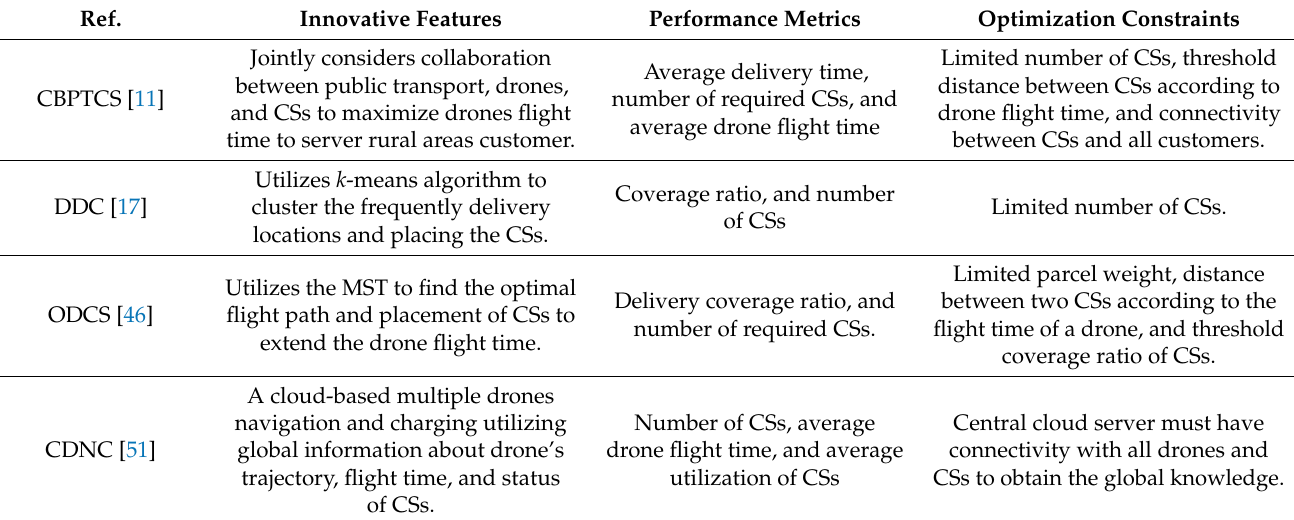
Table 5. Comparison of charging algorithms in drone routing in terms of innovative features, performance metrics, and optimization constraints.